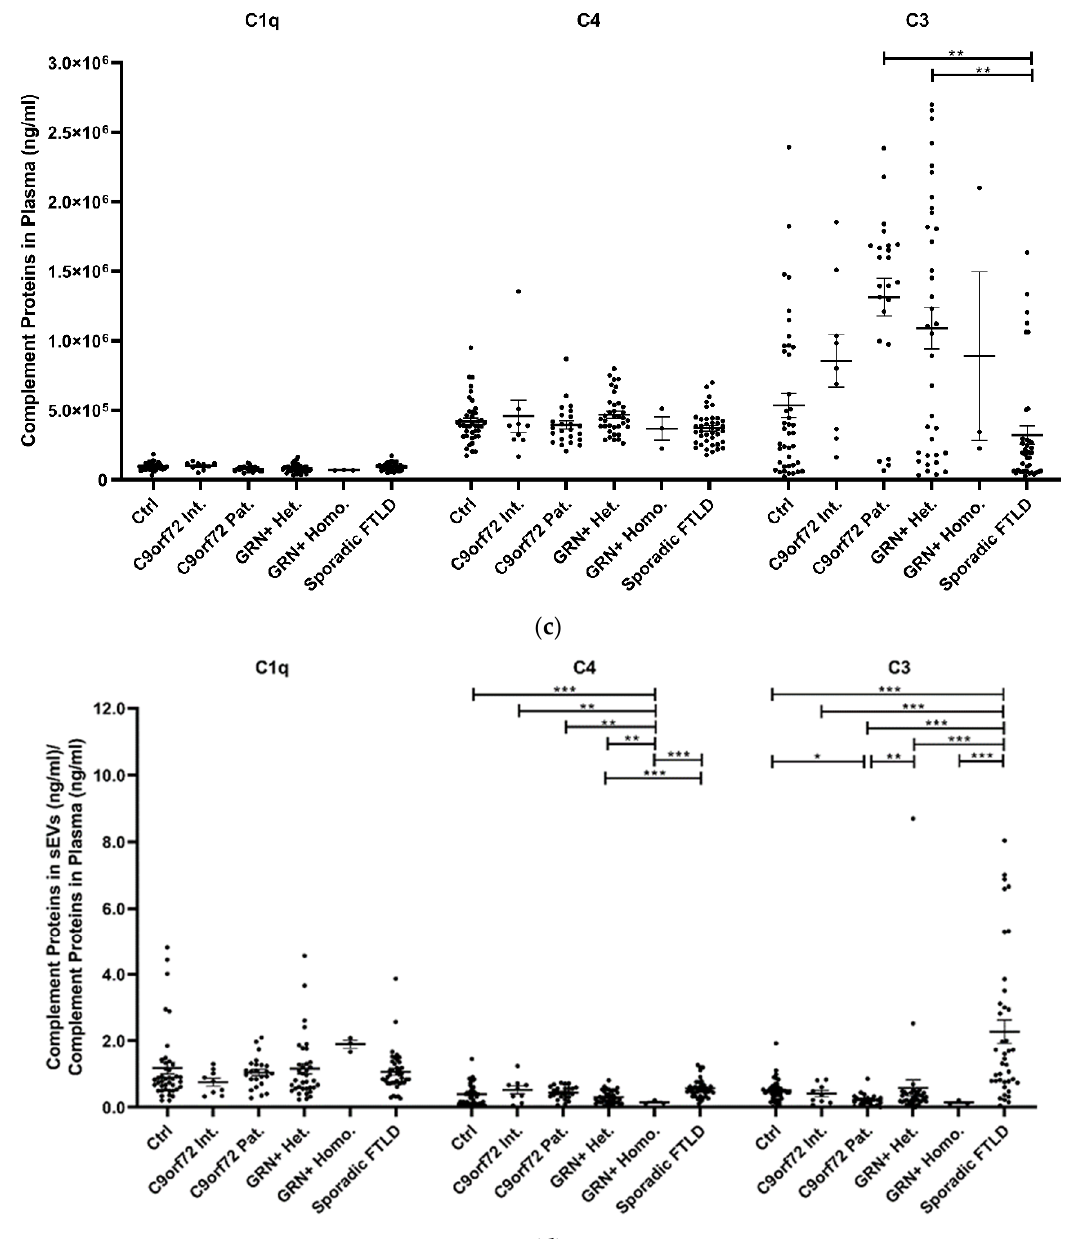
Figure 2. C1q, C4, and C3 proteins ( a ) concentration per sEV (ng/sEV); ( b ) total concentration in sEVs (ng/mL), not normalized values; ( c ) concentration in plasma (ng/mL); and ( d ) total complement protein concentration in sEVs (ng/mL)/complement protein concentration in plasma (ng/mL) ratio in Ctrl, C9orf72 Int., C9orf72 Pat., GRN + Het., GRN + Homo., and Sporadic FTLD. Mean ± SEM; * p < 0.05, ** p < 0.01, *** p < 0.001 obtained by the generalized linear model (adjusted for age) for non-normally distributed variables.